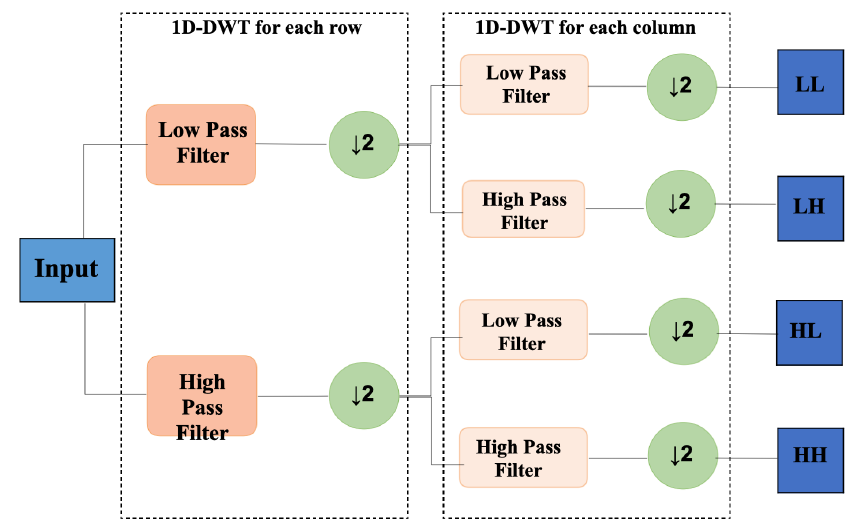
Figure 2. Diagram of the 2D-DWT